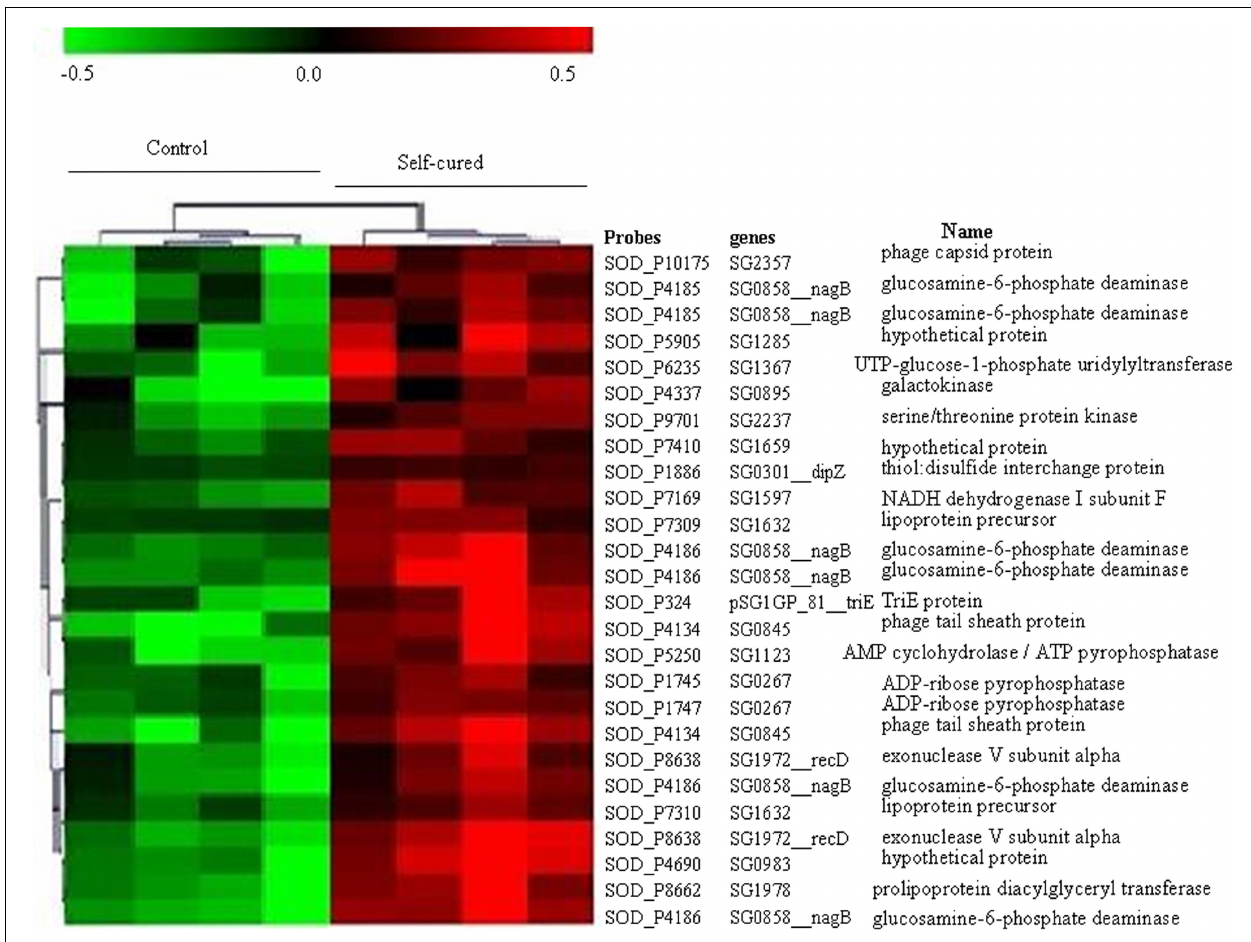
FIGURE 1 | Expression profile of Sodalis glossinidius genes whose transcript levels changed significantly between trypanosome self-cured flies and control flies fed on a non-infected blood meal. This set of genes was extracted from the full data set ( n = 2823) using a SAM procedure with